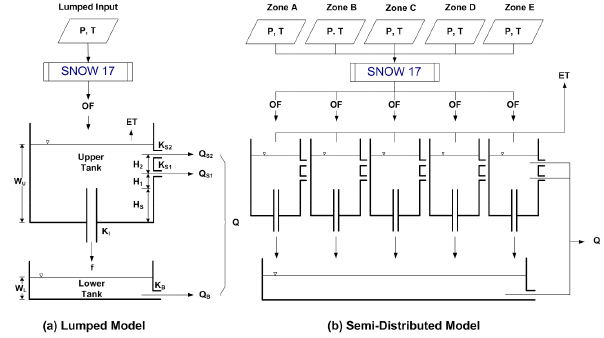
Fig. 3. Details of the proposed approach with the tank model and